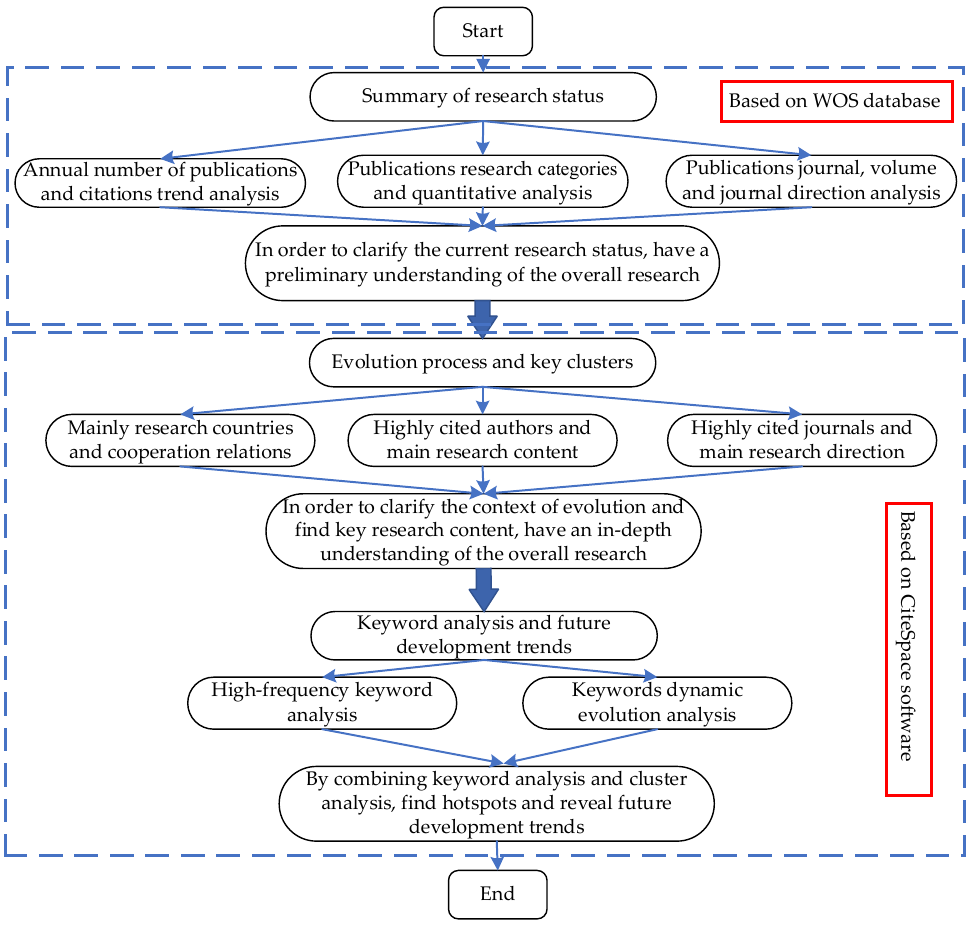
Figure 1. The schematic diagram of the research methods and processes .